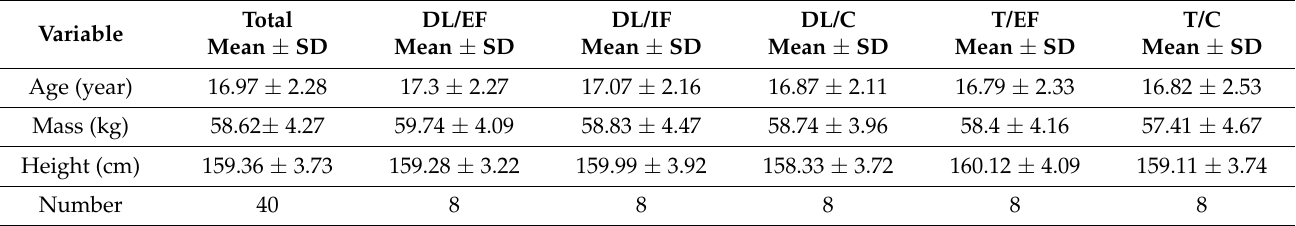
Table 1. Demographic characteristics of the five intervention